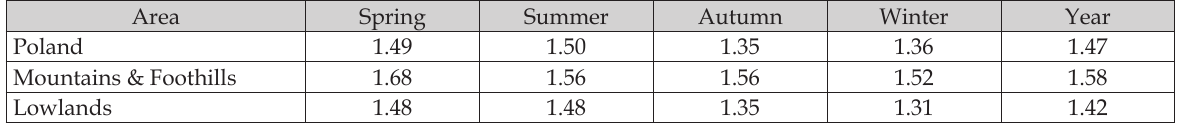
Table 3. Mean intensity ratios of MCP and other precipitation. Period